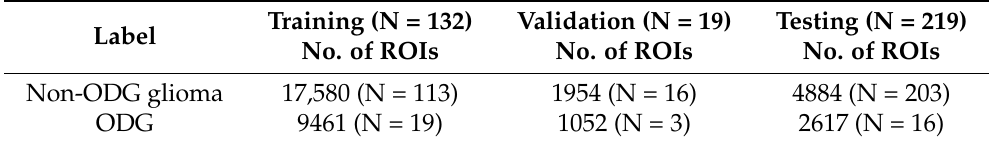
Table 2. Dataset for classifying non-ODG and ODGs gliomas.